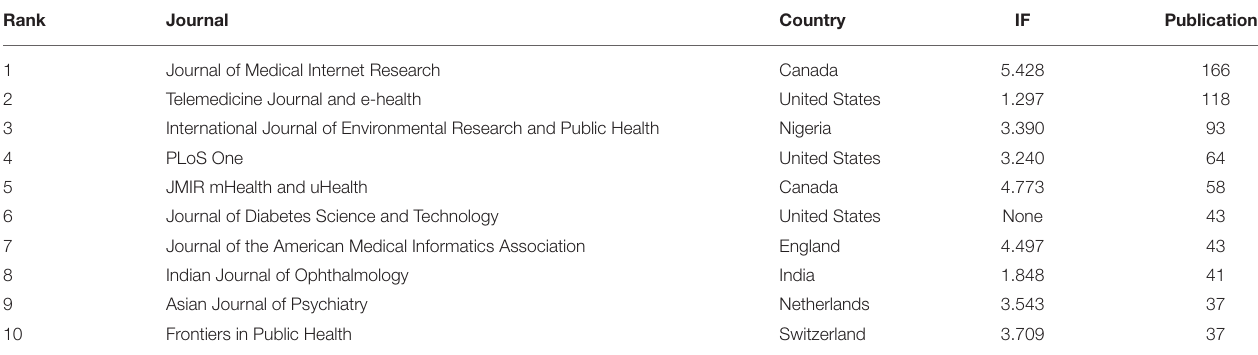
TABLE 1 | Top 10 journals are publishing research on telemedicine research in